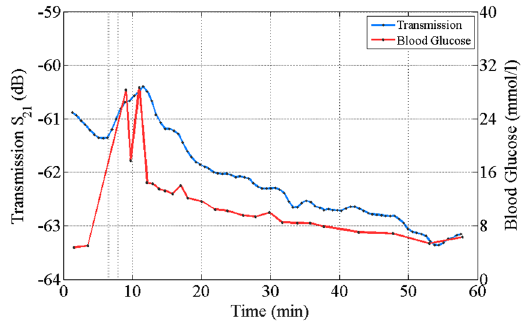
Figure 6. The in-vivo measurements results and comparison with invasive methods. The relation between measured transmission coefficient and glucose reading from a conventional glucose meter with time. There is a delay (~3 min) in the glucose spike between invasive method and our peripheral data. GlucoWise’s conversion to mmol/l matches well with the invasive methods. The trial was conducted at Roehampton University,